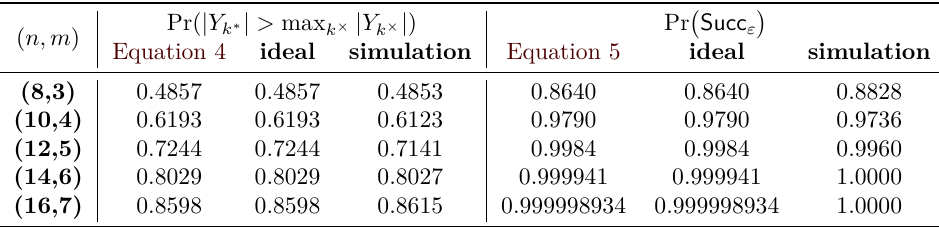
Table 2: The simulation and theoretical (ideal) analysis results for n = 2 m + 2 where m = { 3 , 4 , 5 , 6 , 7 } by targeting at a n -bit random